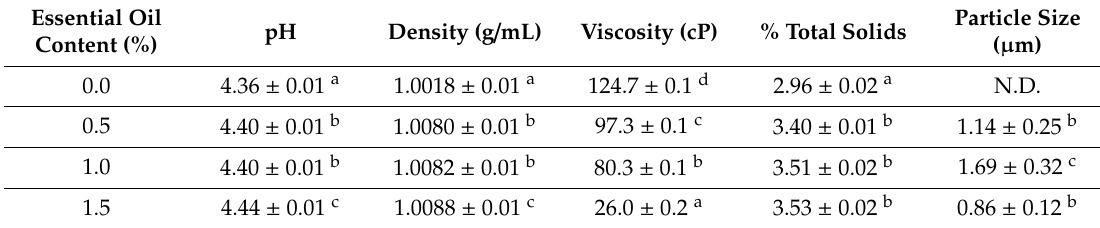
Physical-chemical properties of the chitosan (CS) + Ruta graveolens L. essential oil (RGEO)